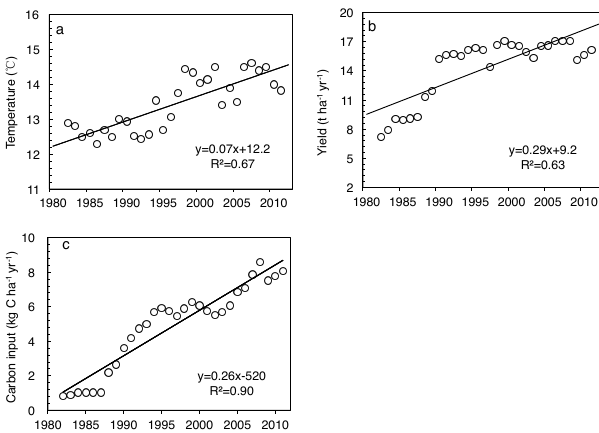
Figure 3. Regression analysis of driving factors with the years in Huantai. (a) temperature vs. year, (b) yield vs. year and (c) carbon input vs.